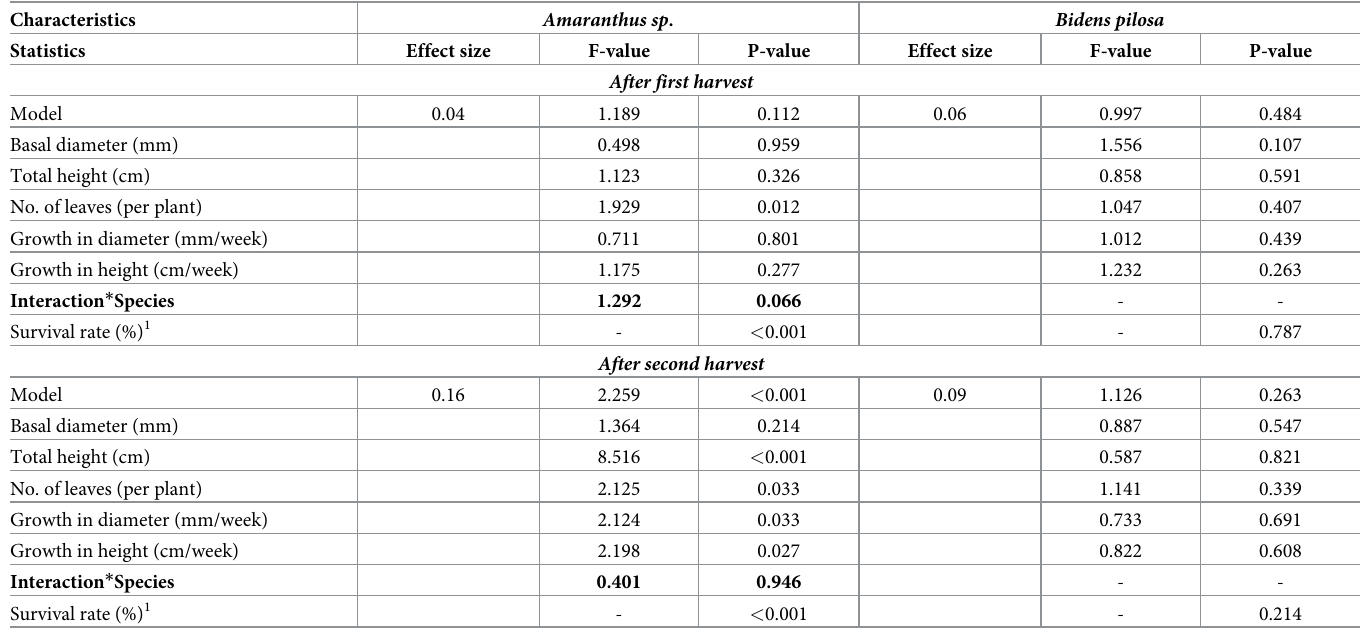
Table 7. Results of the Multivariate Analysis of Variance and log-linear analysis for the impact of the interaction of the treatments on the study species.